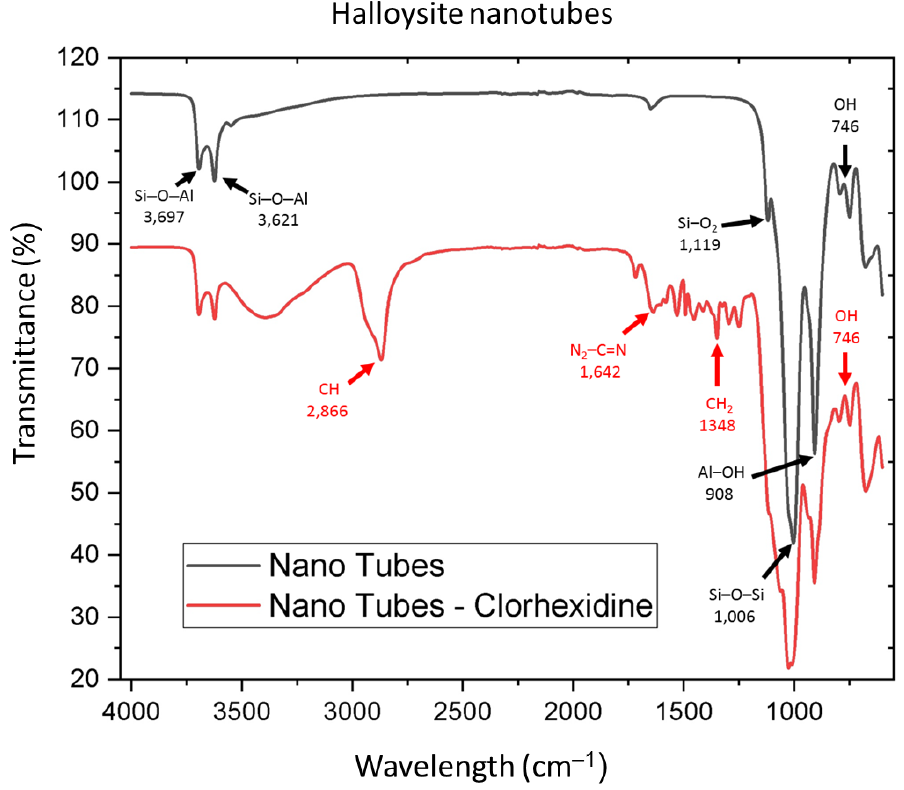
Figure 2. Spectroscopy of halloysite nanotubes and chlorhexidine nanotubes.